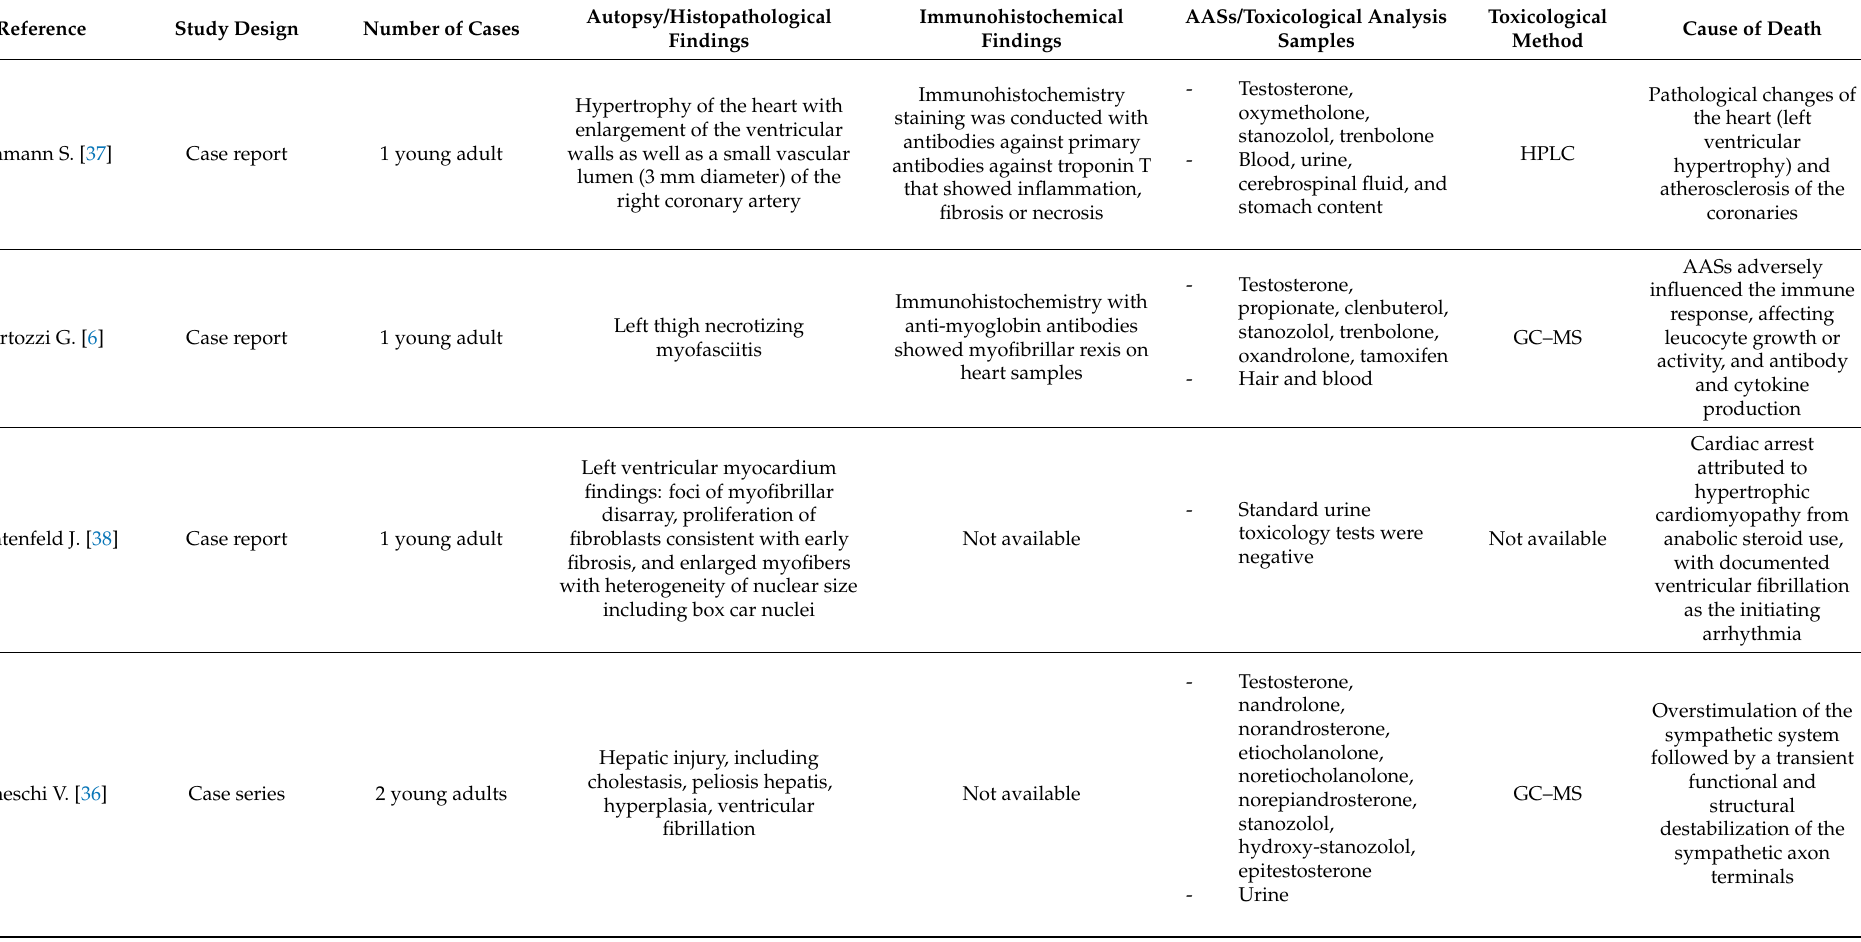
Table 1. Summary of the details of the systematic